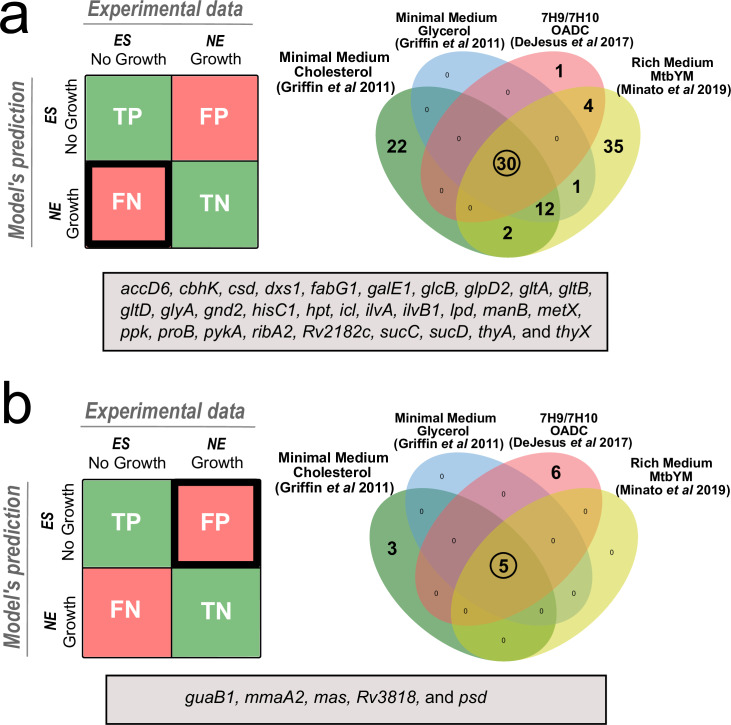
False Negative and False Positive predictions in the evaluated media.(a) Venn diagram for predicted false negative (FN) genes; (b) Venn diagram for predicted false positive (FP) genes. Genes in the grey box represents the intersection of all FN and FP genes in the four media. Genes are classified as True-positives (TP) if model simulation predicts no growth when essential genes are deleted, False-positives (FP) if model simulation predicts no growth when not essential genes are deleted, True negatives (TN) if model simulation predicts growth when not essential genes are deleted and False negatives (FN) if model simulation predicts growth when essential genes are deleted.